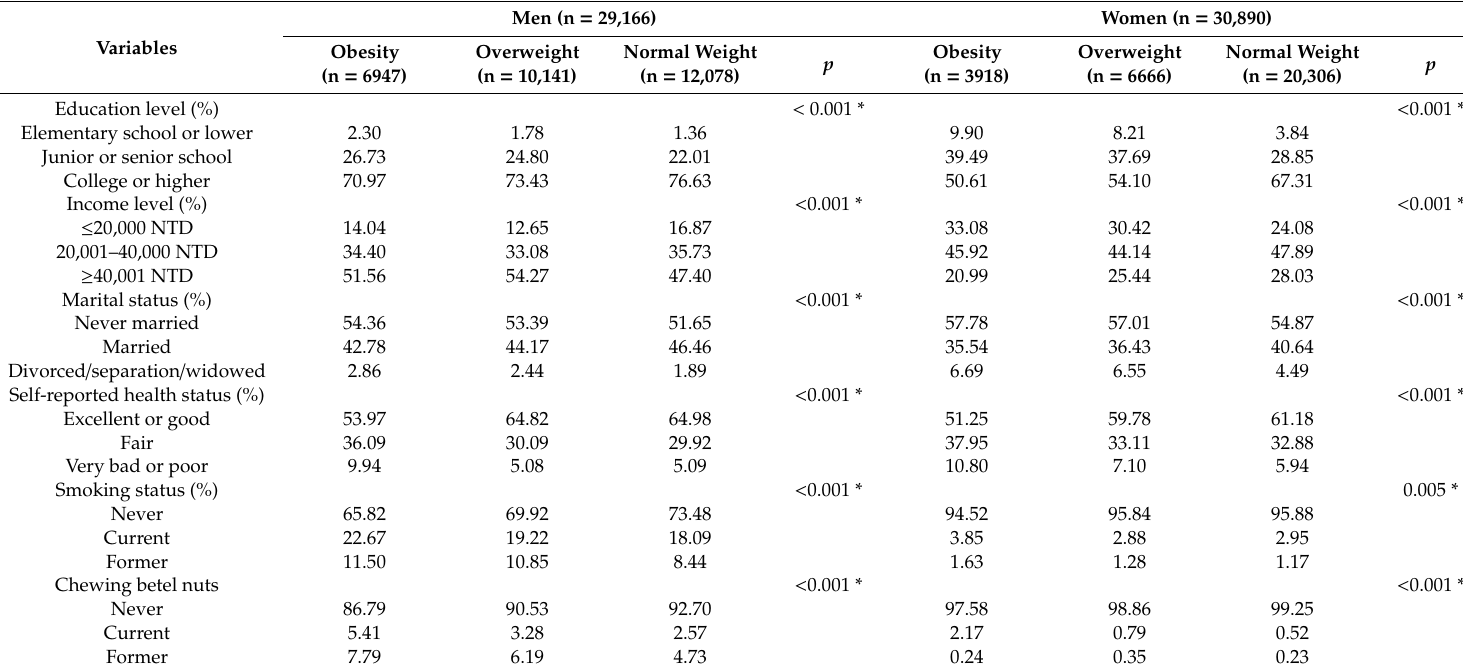
Table 2. Demographic characteristics of the study